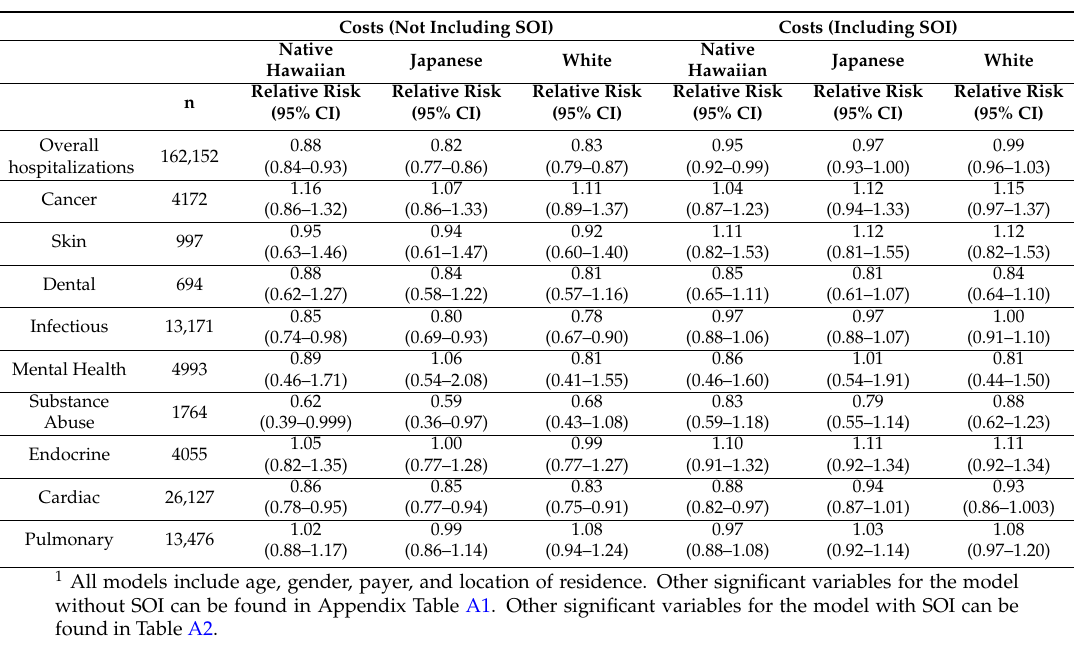
Table 2. Results of Multivariate Analysis for Costs with and without Severity of Illness (SOI) by race/ethnicity with Micronesians as the reference group. 1